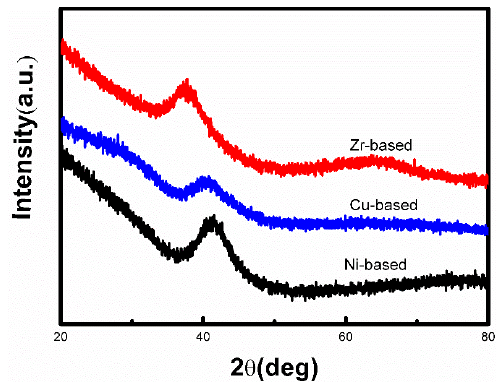
Figure 1. XRD patterns of as-prepared Ni-based, Zr-based, Cu-based BMG pins.